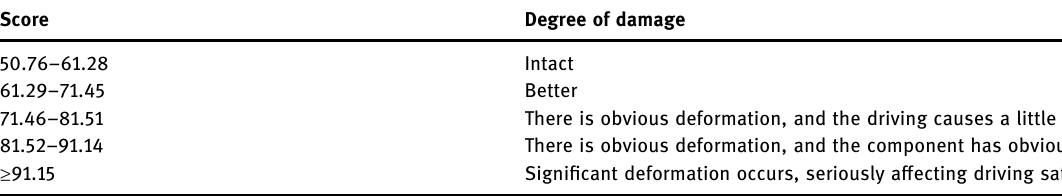
Table 2: Comparison of score and injury